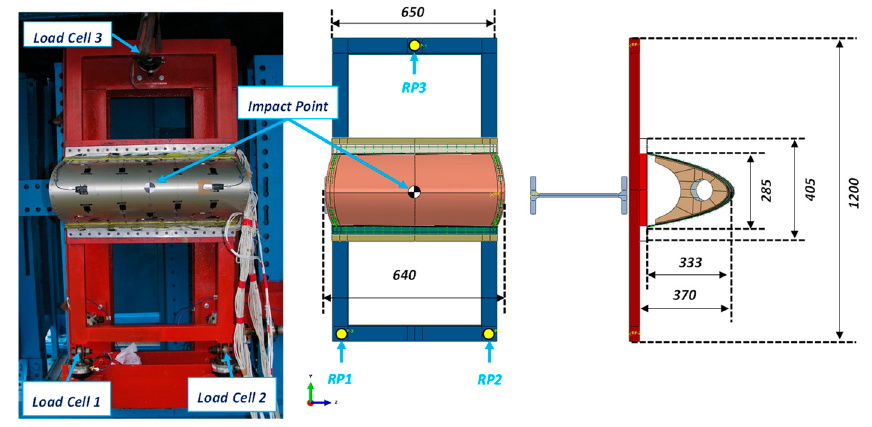
Figure 1. Load cells positions: experimental set up ( left ) and numerical model ( right ).